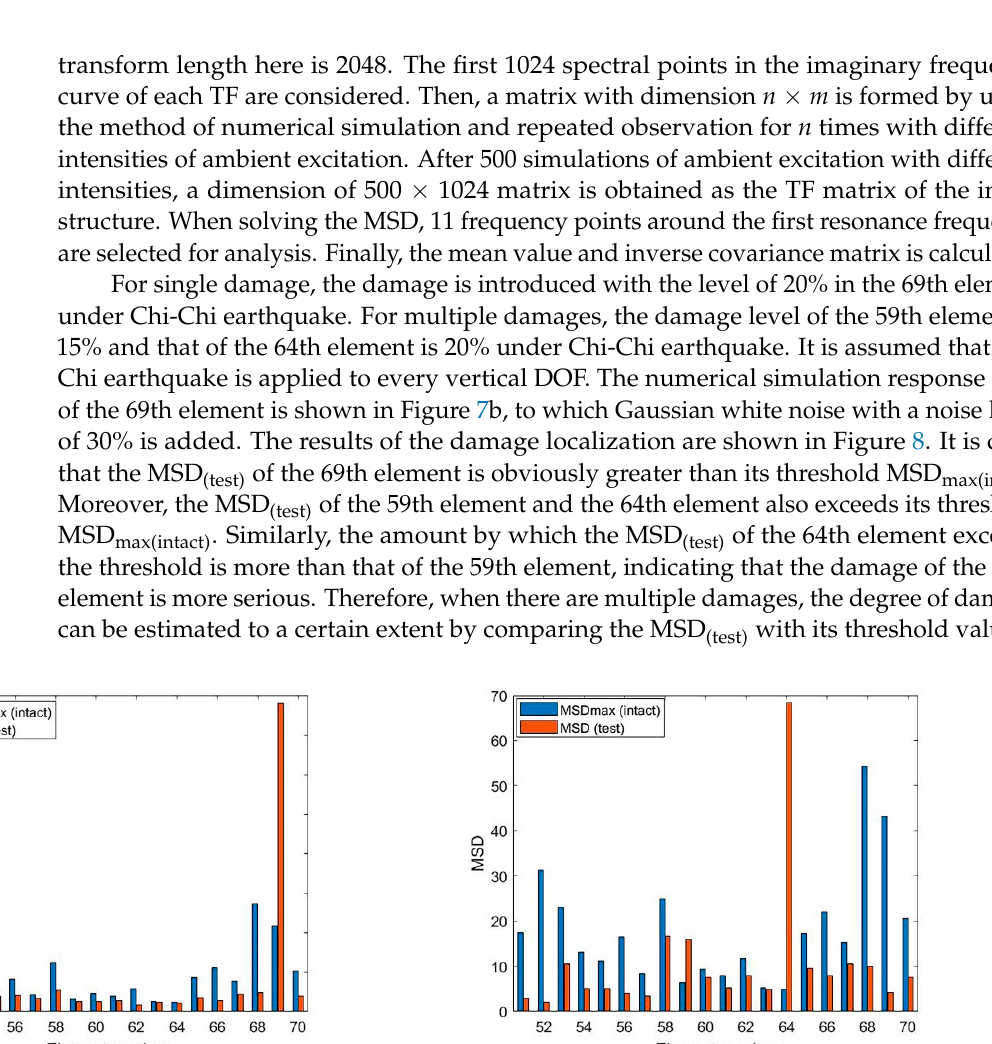
Figure 7. ( a ) Time history of strain response in the 69th element under ambient excitation; ( b ) time history of strain response in the 69th element under Chi-Chi earthquake.